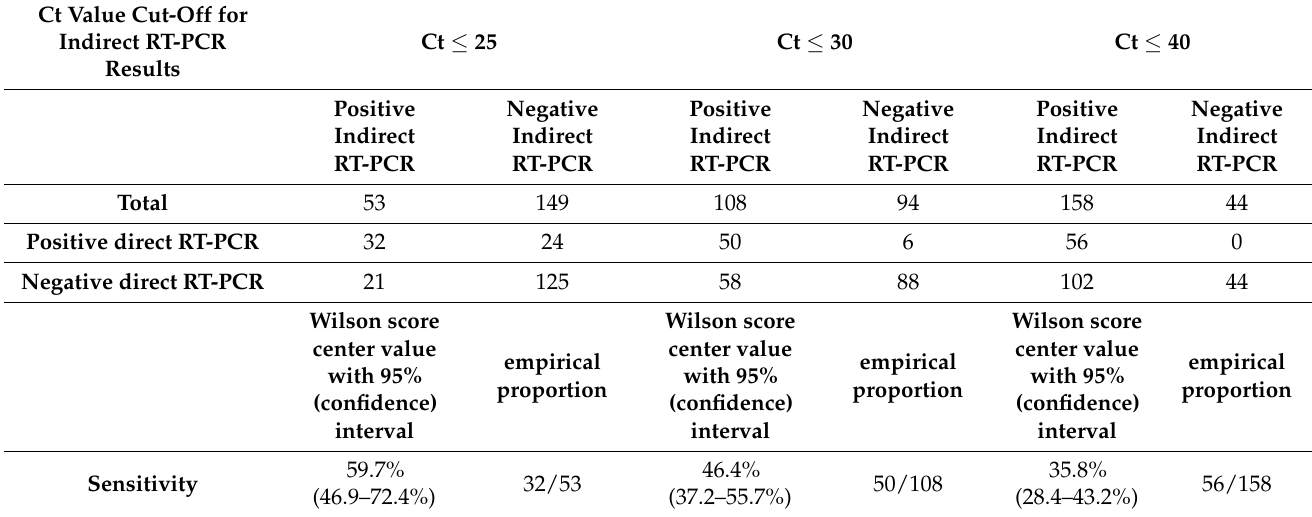
Table 4. Binary results and sensitivity of gargle water direct RT-PCR with respect to Ct value cut-offs for paired oro-nasopharyngeal indirect RT-PCR results.